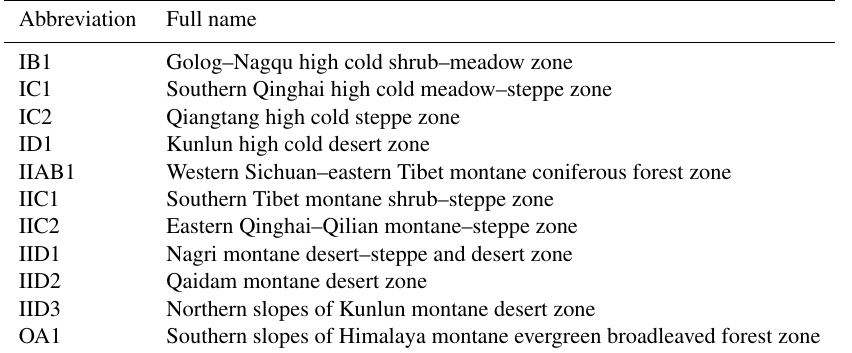
Table A5. List of abbreviations of eco-geographical regions of the